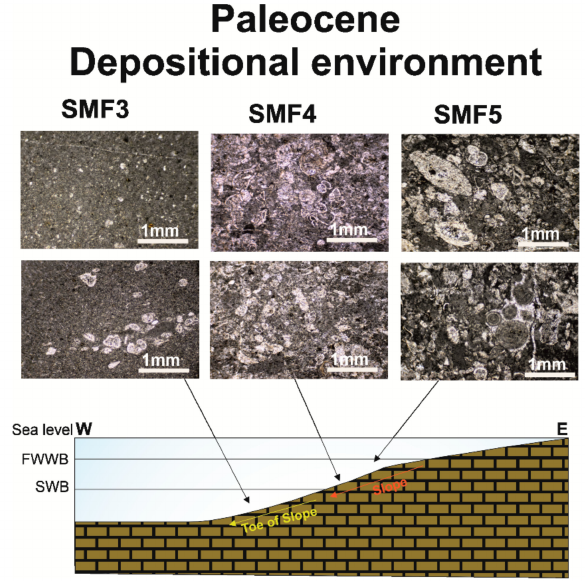
Figure 22. Microfacies types and the corresponding depositional environments/Facies Zones during the